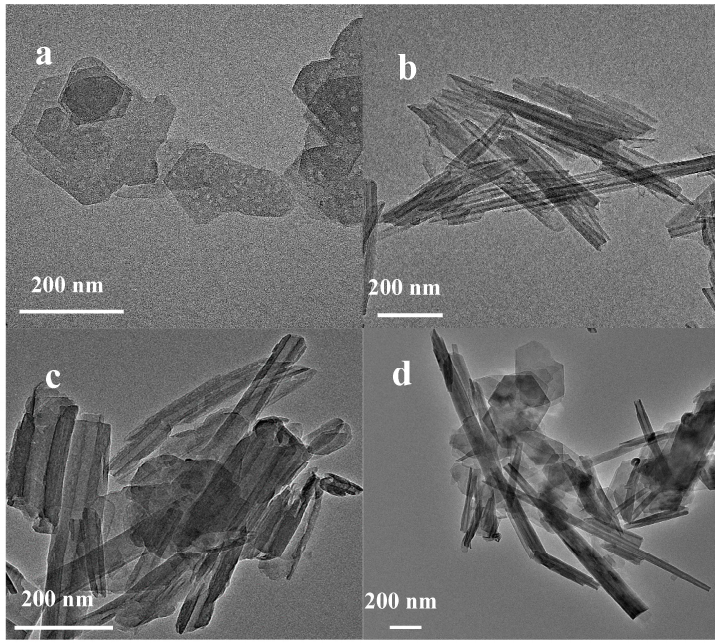
Figure 3. TEM images of kaolinite and halloysite. ( a ) M; ( b ) H; ( c ) S; ( d ) MH.